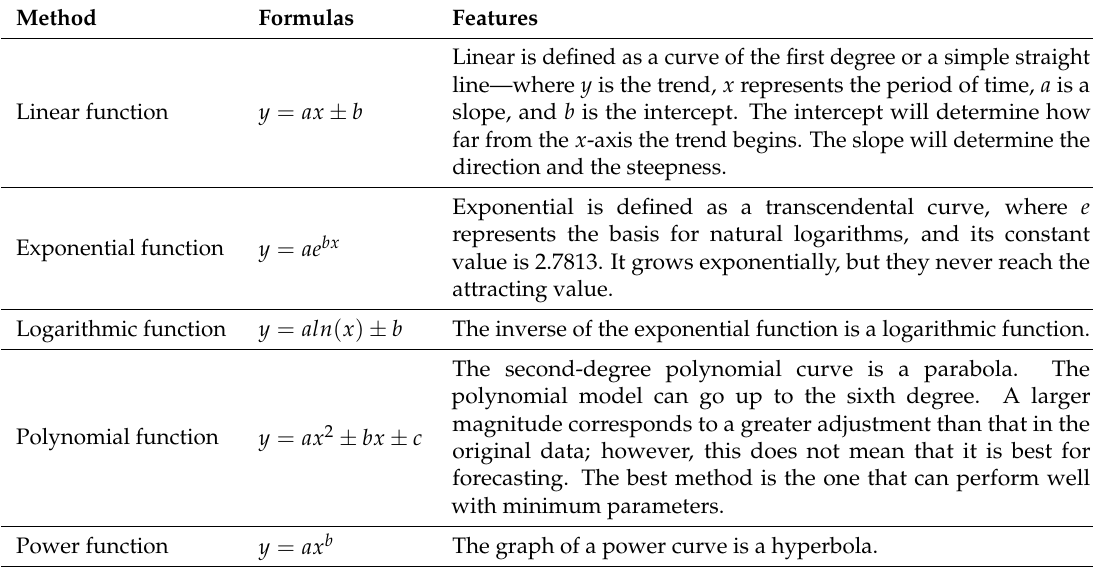
Table 1. Classical methods, equations, and